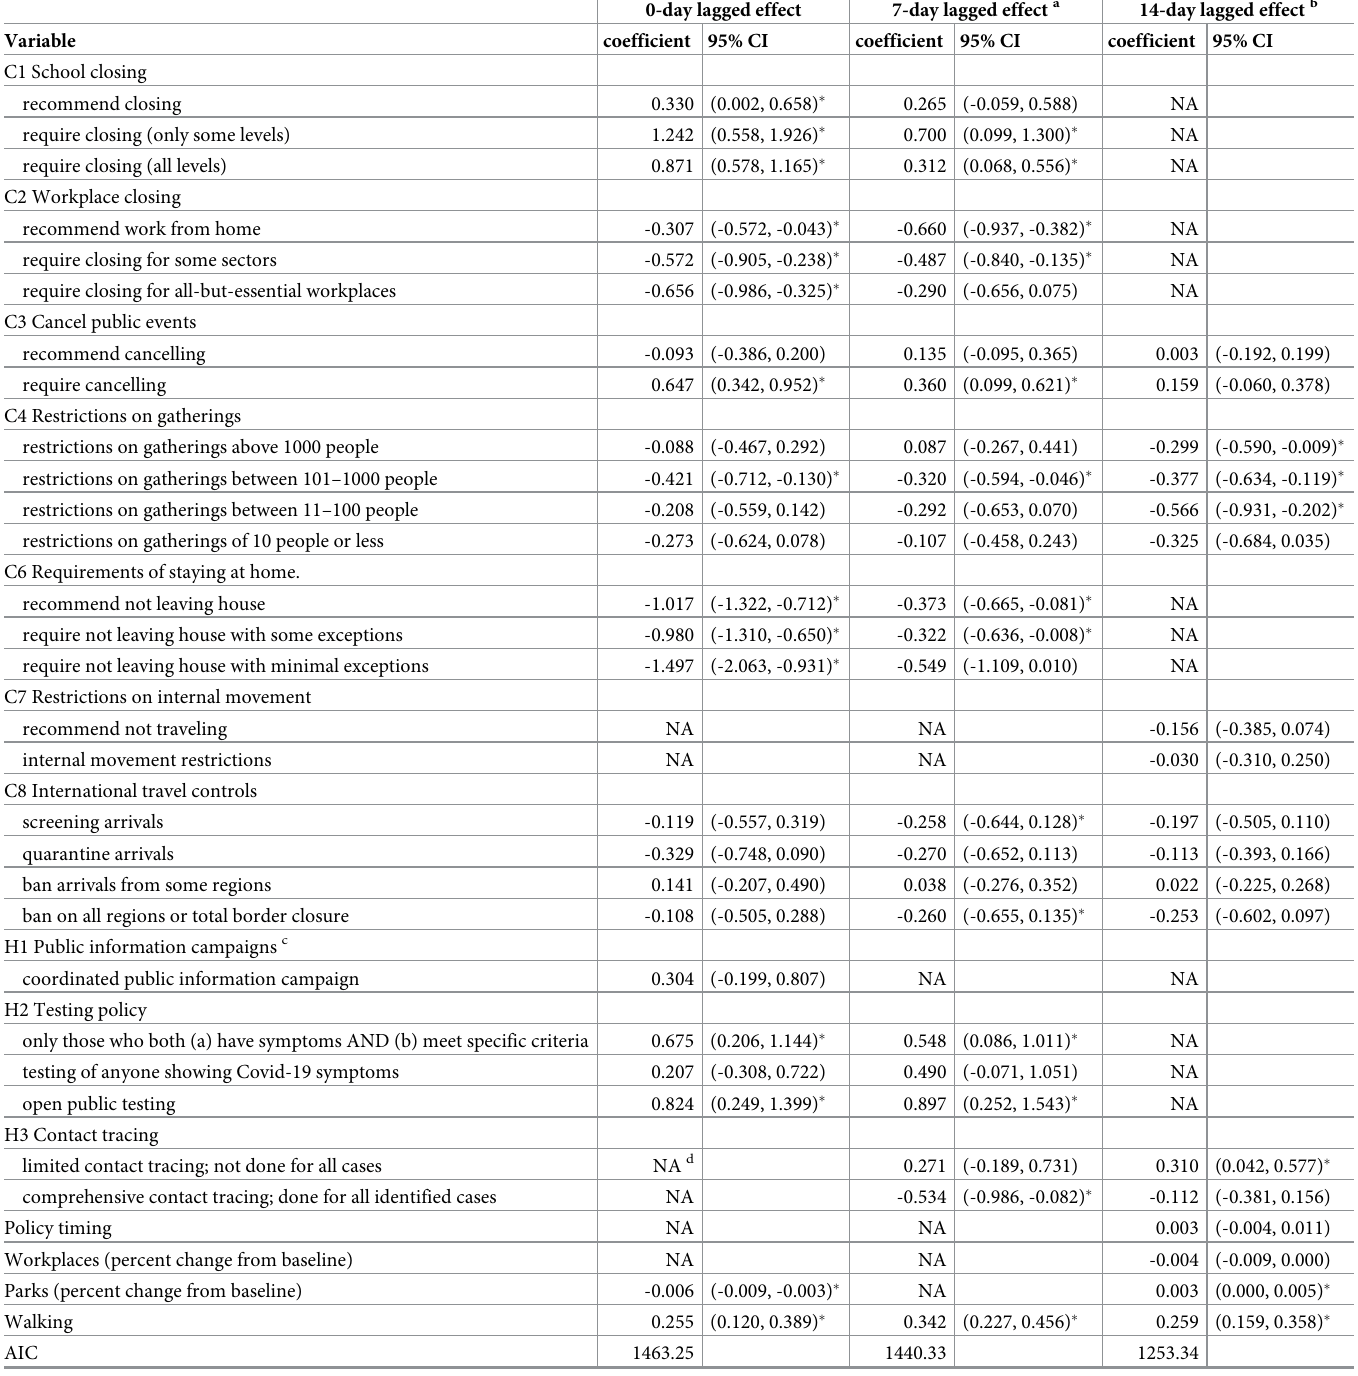
Table 4. Estimated effects on effective reproduction number with specific